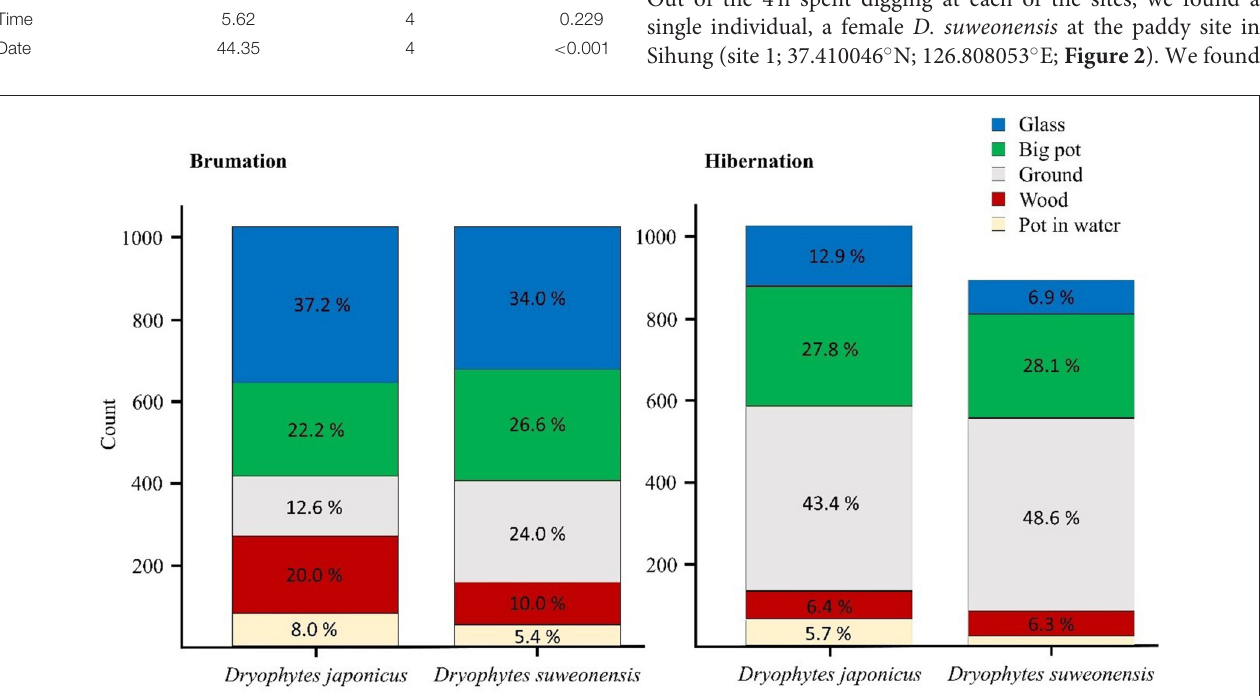
FIGURE 5 | Microhabitat variation displayed by Dryophytes suweonensis and D. japonicus during brumation and hibernation with corresponding frequency. The variation in the total number of counts was due to the death of three individual D. suweonensis during the period before hibernations. The non-annotated stack “pot in water” for D. suweonensis is